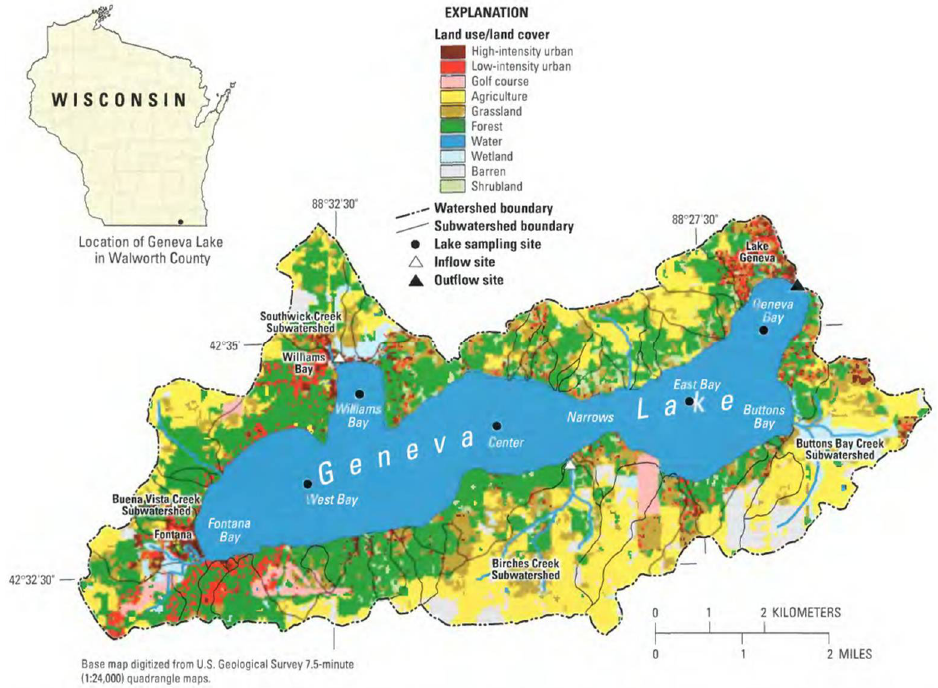
Figure 5. Geneva Lake watershed land use [13].